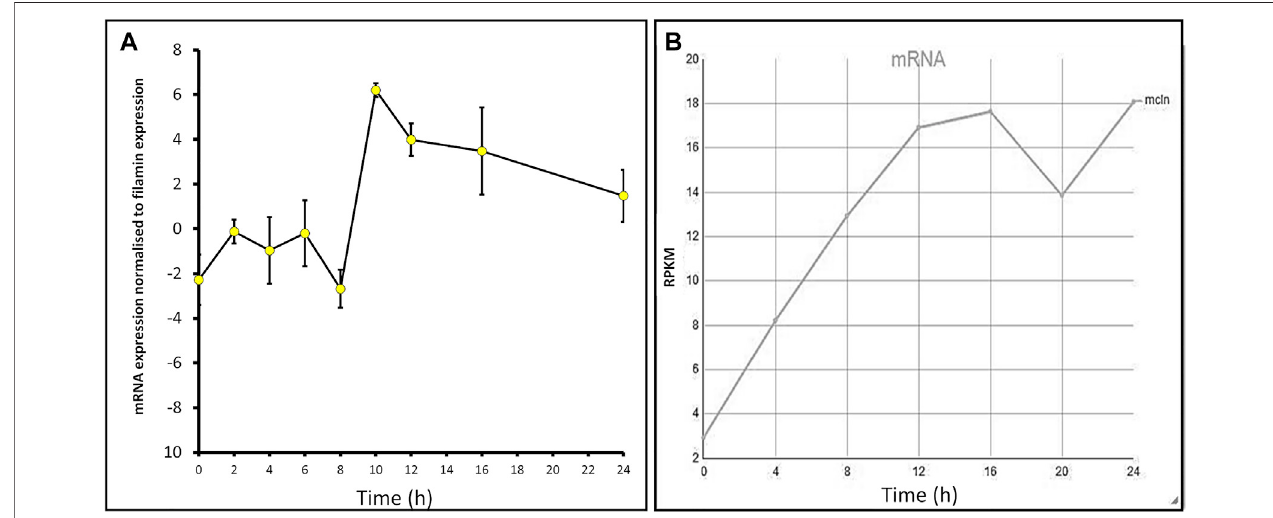
FIGURE 1 | mcln mRNA expression increases throughout development in Dictyostelium AX2 and AX4. (A) Semiquantitative RT-PCR was used to determine the mcln expression in AX2 throughout development presented normalised to fi lamin expression. RNAwasextracted from cells developing on water agar every2 h for 24 h in two separate experiments. Error bars are standard errors of the mean. (B) Developmental timing of expression of mcln in AX4 as measured by RNA-Seq. Reads per kilobase per million (RPKM) over 24 h. Published on DictyBase (Parikh et al., 2010; Stajdohar et al., 2017).